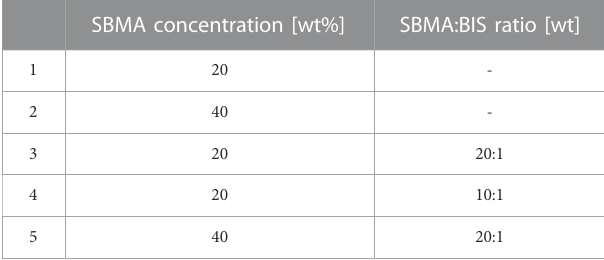
TABLE 1 Composition of SBMA monomer and BIS cross-linker